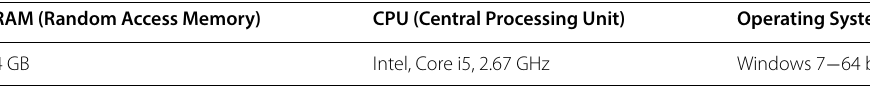
Table 2 Machine specification RAM (Random Access